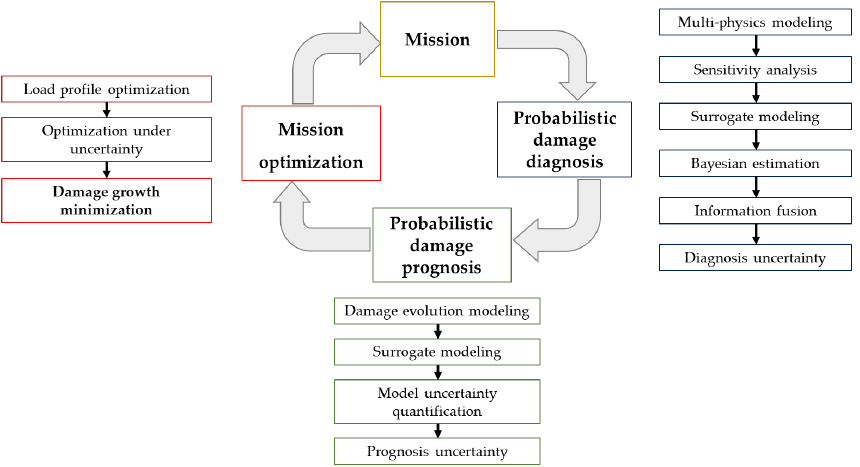
Figure 12. Components of a digital twin for damage-tolerant planning